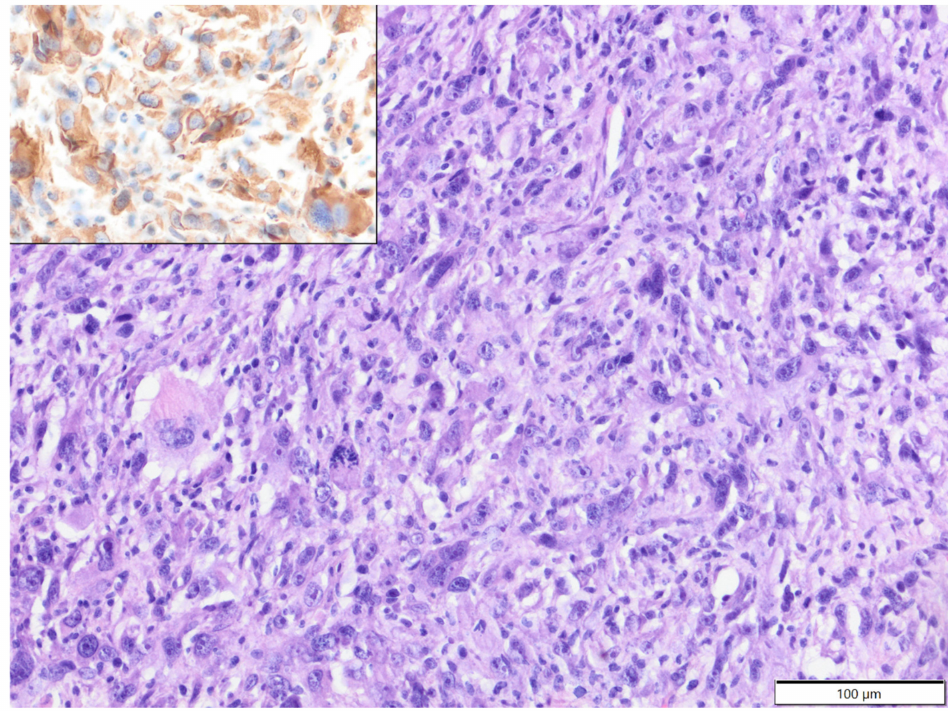
Figure 5. Anaplastic sarcoma with giant cells, neck, degu. The tumour cells show high levels of anapla- sia and multinucleation. HE. Inset: tumour cells show cytoplasmic expression of vimentin. IHC. Detailed information about the incidence of particular tumour types in small mammal pets, depending on sex and age, is summarised in Table